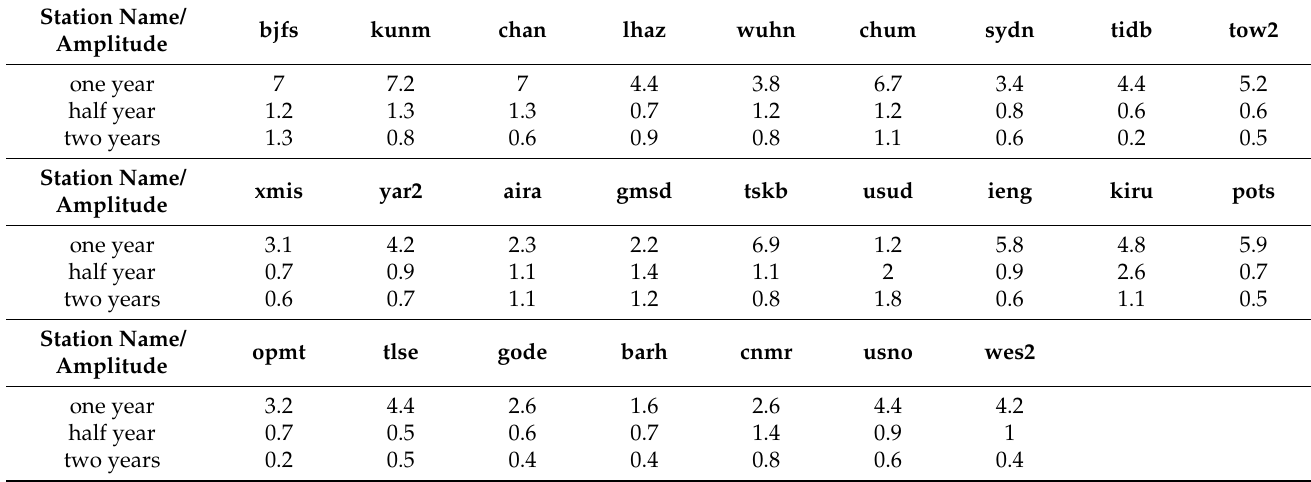
Table 5. Corresponding amplitude values (mm) of the main periodic terms of the elevation nonlin- ear LS modeling of 25 CORS stations around the world.